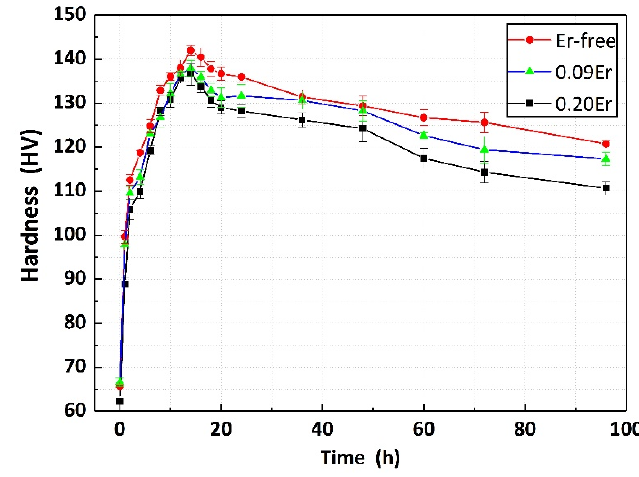
Figure 1. Age-hardening curves of studied alloys at 165 °C.